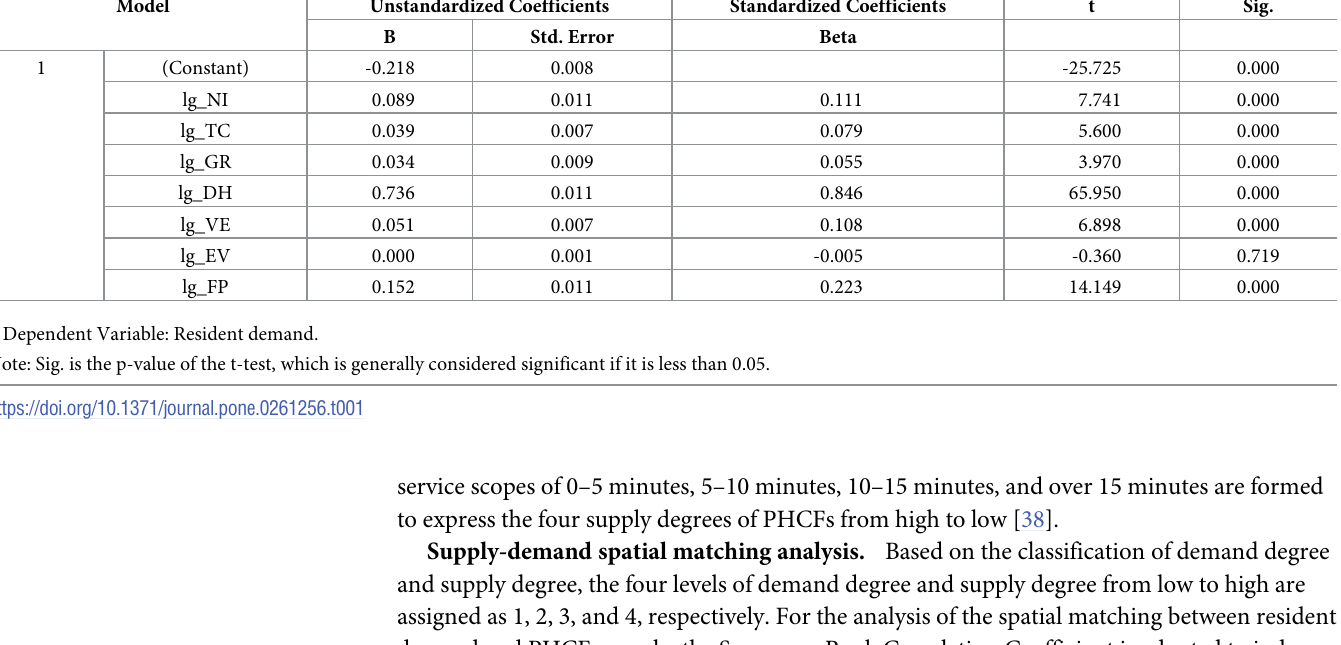
Table 1. Results of multiple linear regression analysis on the evaluation factors of resident demand.